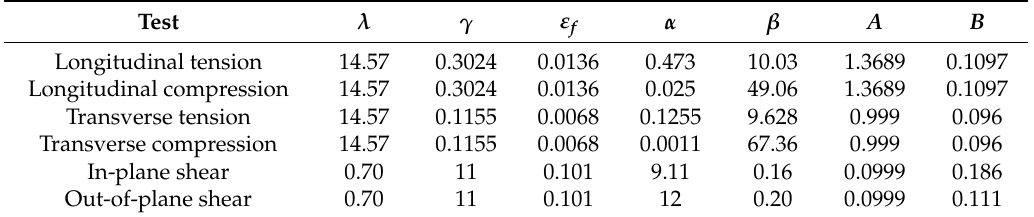
Table 2. Fatigue material constants in Shokrieh model for AS4 3501-6.